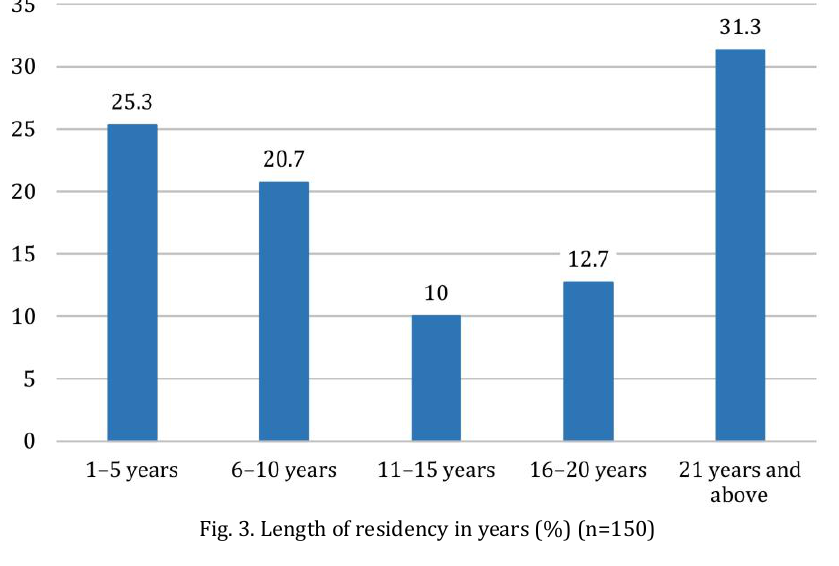
Fig. 3. Length of residency in years (%) (n=150)